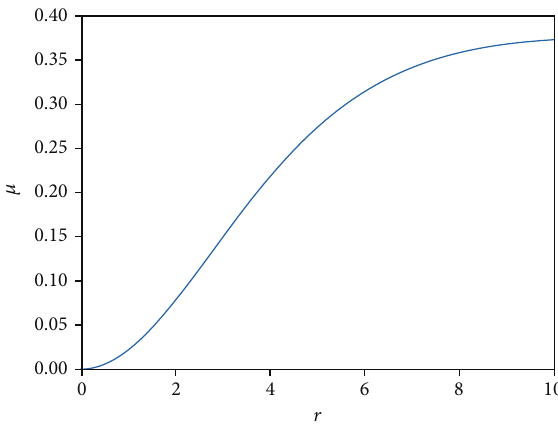
Figure 6: Compacti fi cation μ against radial distance r . Þ against t